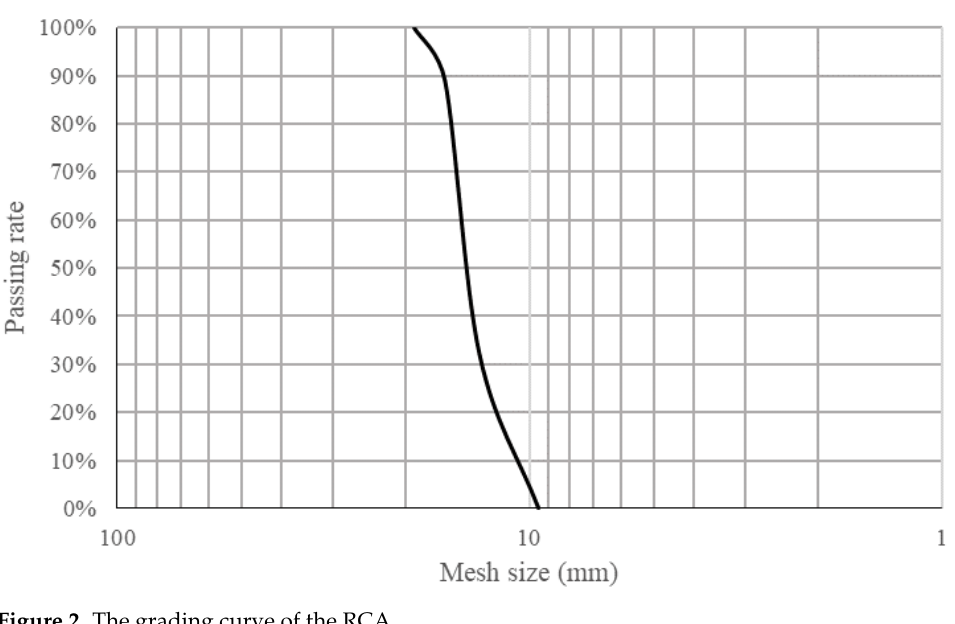
Figure 2. The grading curve of the RCA. Table 1. Properties of the raw RCA.